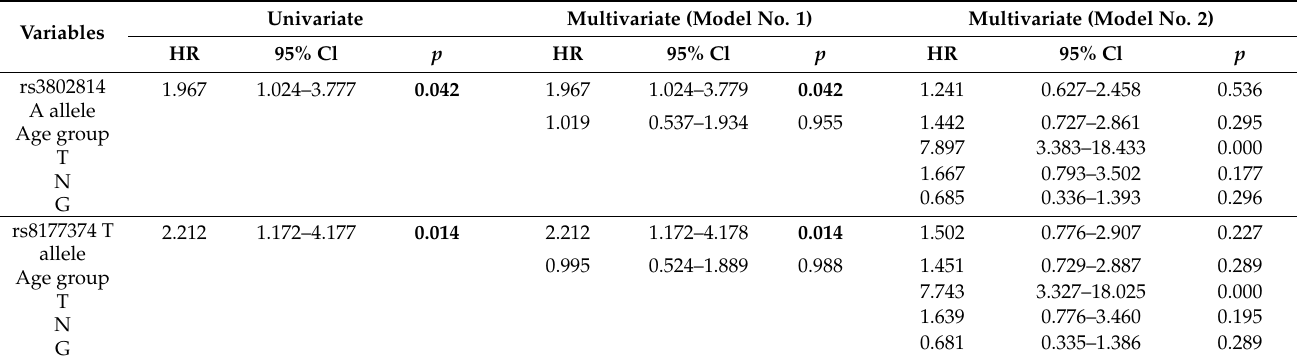
Figure 2. Kaplan–Meier survival curve for the association between the T allele of rs8177374 and OS. Using the univariate Cox regression analysis (Table 4), we determined that patients with the A allele of TIRAP rs3802814 had shorter OS (HR = 1.967, 95% CI 1.024–3.777, p = 0.042) compared with non-carriers. Table 4. Univariate and multivariate Cox regression analysis between the rs3802814 A allele and rs8177374 T allele and